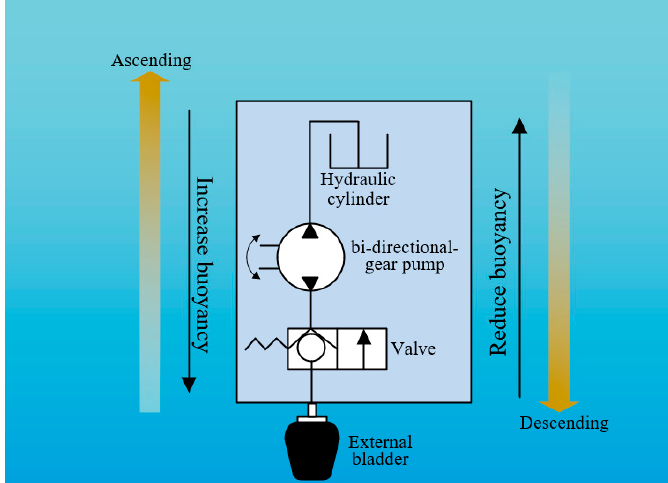
Figure 2. Schematic diagram of the buoyancy regulation system.